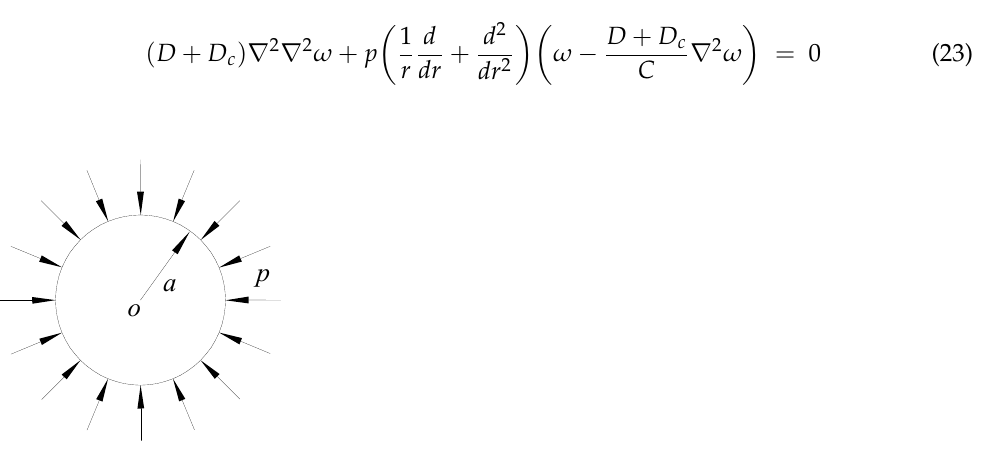
Figure 5. Circular SP-HCs subjected to uniform pressure.